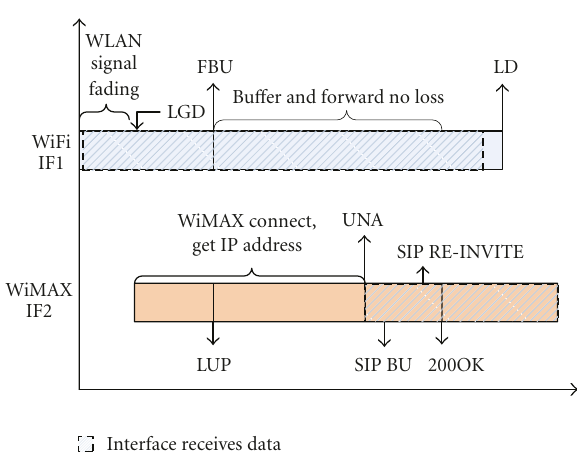
Figure 5: Network switching in